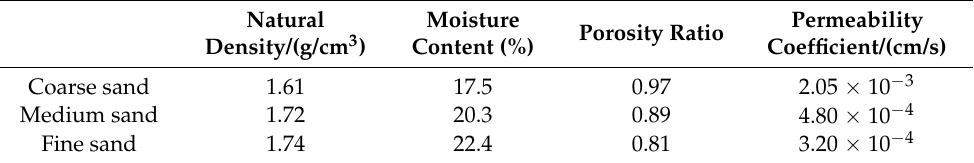
Table 4. Geotechnical parameters of sand.